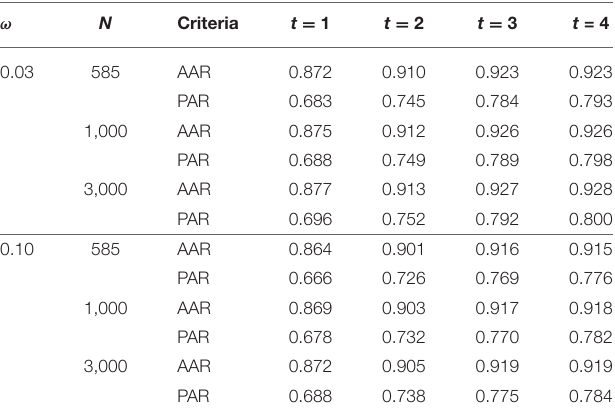
TABLE 5 | The averaged attribute-wise and pattern-wise agreement rates (AARs and PARs) between the true and estimated α across 50 repetitions under each simulation